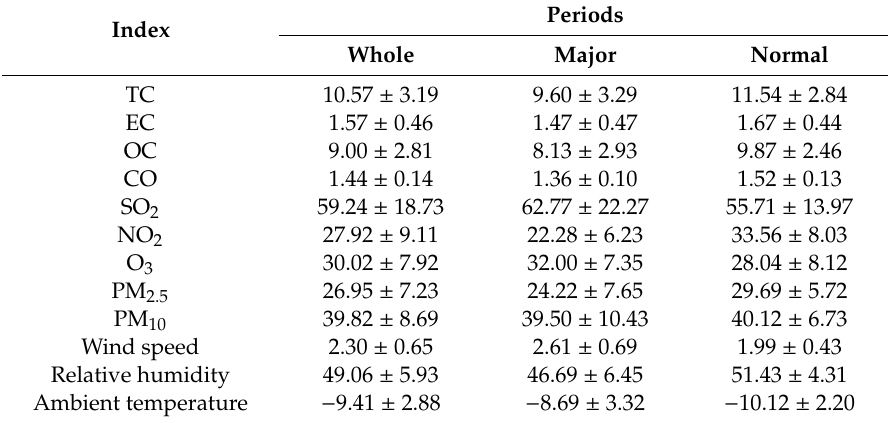
Table 1. Daily average values of pollutants (i.e., total carbon (TC), organic carbon (OC), elemental carbon (EC), CO, SO 2 , NO 2 , O 3 , particulate matter (PM 10 and PM 2.5 )) and meteorological elements (i.e., ambient temperature, relative humidity, and wind speed) in di ff erent periods (i.e., major period and normal period) of the Spring Festival in Changchun. Except for CO, the unit of remaining pollutants is µ g / m 3 , while for CO, it is mg / m 3 ; the units of wind speed, relative humidity, and ambient temperature are m / s, %, and ◦ C,